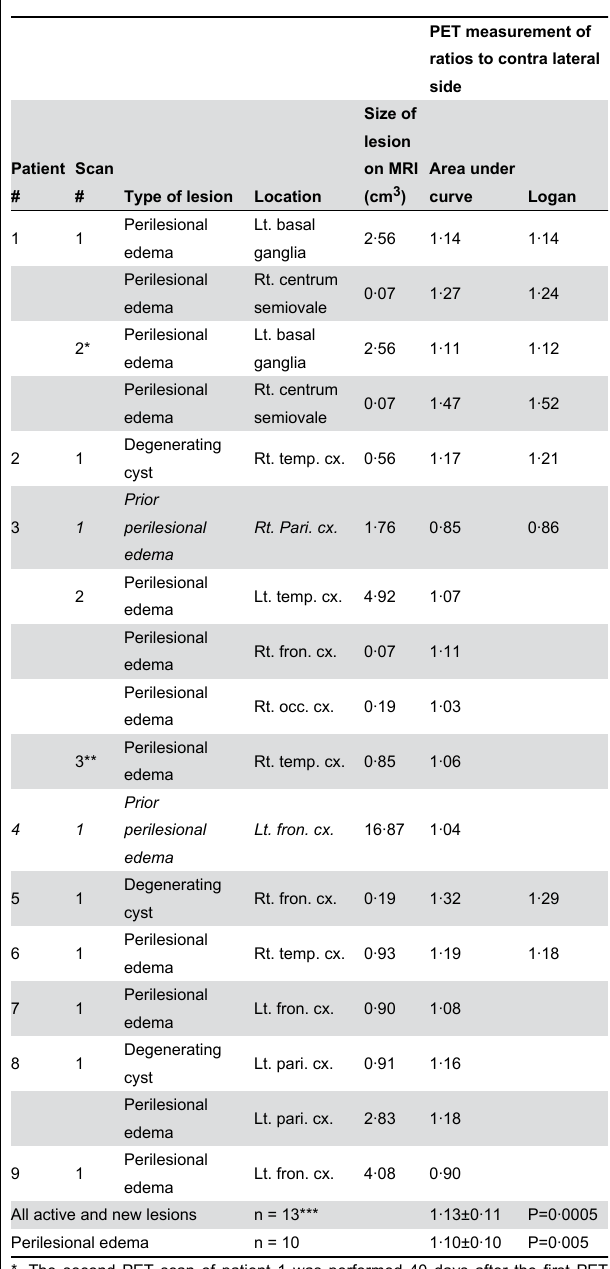
the 6 with current perilesional edema (patients 1, #3-scans #2 and #3, #7, and #8) presented with seizures or focal manifestations and the remaining patients (#6 and #9) were asymptomatic but were found to have perilesional edema at the time of a routine follow up MRI scan. Two subjects who had degenerating cysts (patients 2, 5), presented with seizures due to the studied lesion and underwent PET scans remote from the clinical event. Except for patient 9, evaluated calcified lesions demonstrated no perilesional edema in their